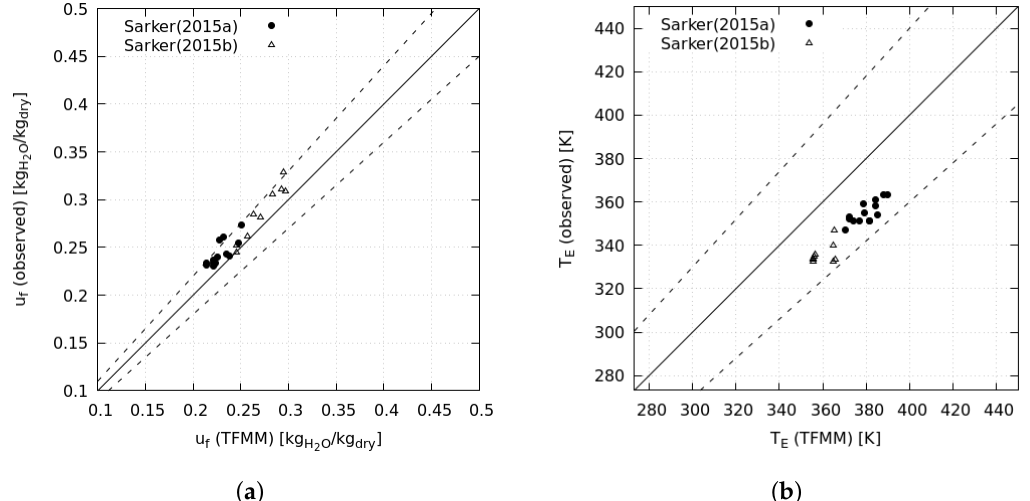
Figure 5. Simulation vs. experimental data: u f ( a ) and T E ( b ) of the case study; values on the dot lines represent a prediction error of ± 10%.